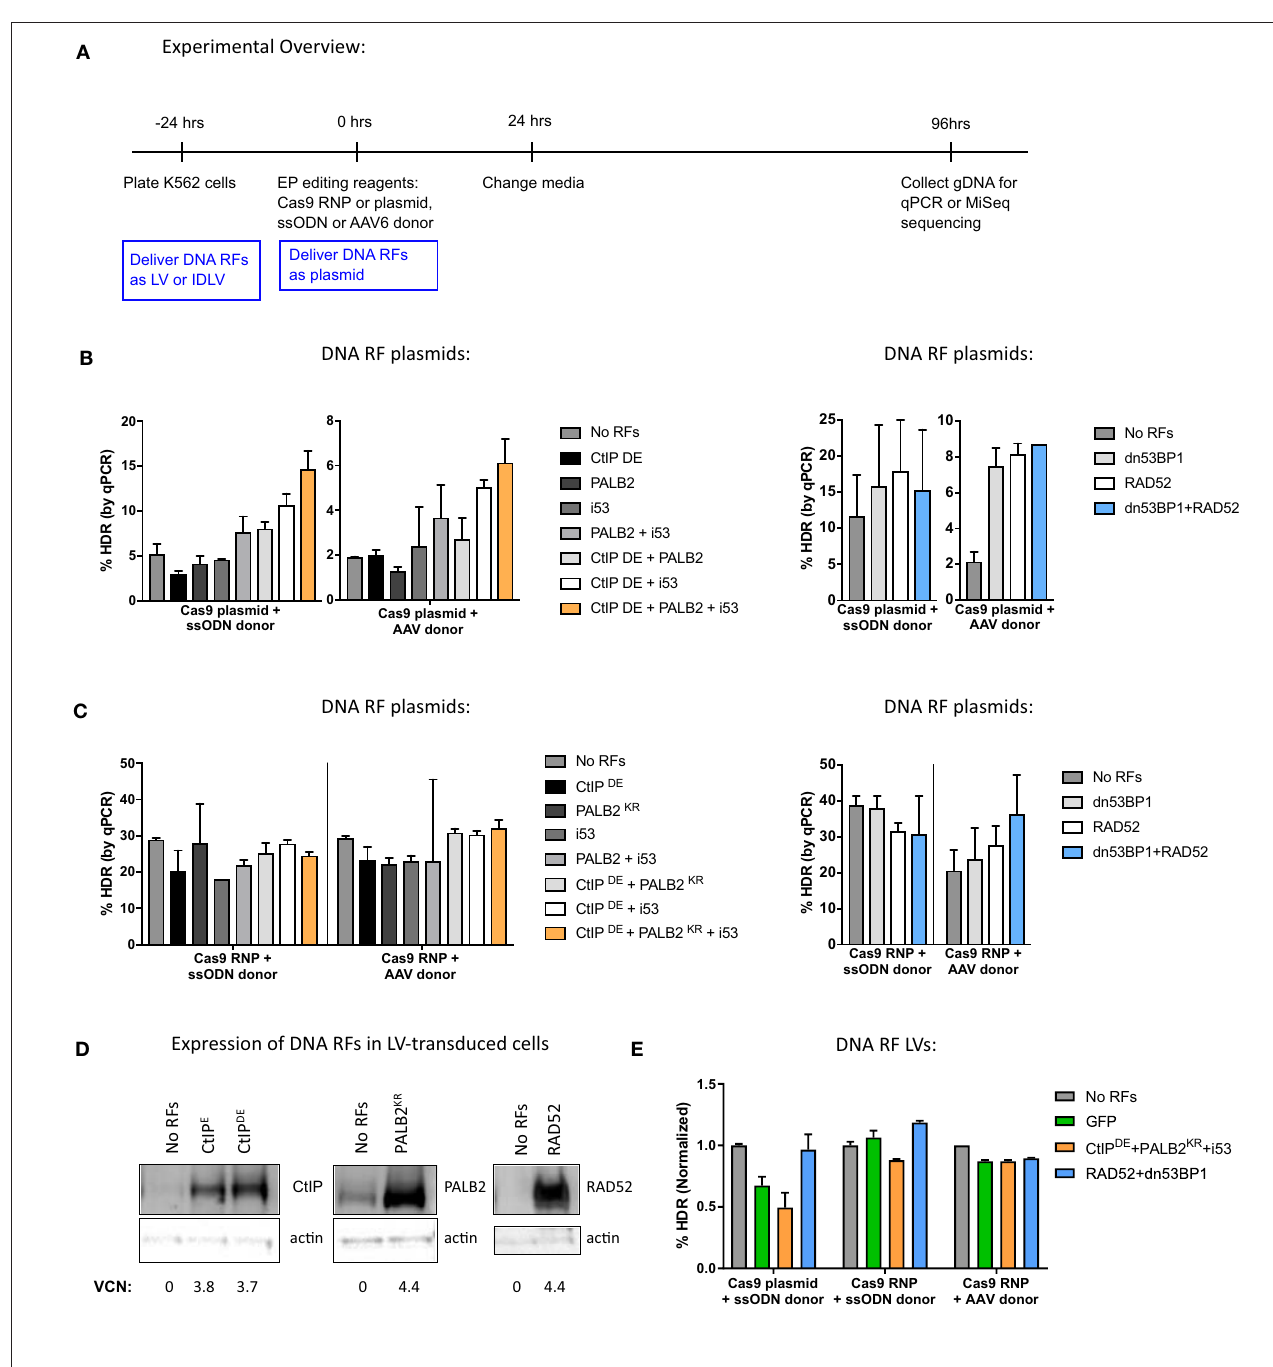
FIGURE 1 | The method for delivery of DNA repair factors (RFs) for global overexpression in K562 differentially affects gene editing outcomes. (A) Experimental overview of K562 cell transduction and electroporation for delivery of DNA RFs and editing reagents. DNA RFs delivered as plasmid were co-electroporated with editing reagents, while delivery of DNA RFs as LVs occurred 24h prior to electroporation. (B,C) Cas9 nuclease was delivered either as plasmid (1 µ g) or RNP (100 pmol Cas9 protein + 4.5 µ g of IVT sgRNA); donor template was delivered either as ssODN (3 µ M) or AAV6 (MOI 2e4). DNA RFs were delivered as a plasmid. HDR levels were measured by qPCR. n = 2 biological replicates for CtIP DE + PALB2 KR + i53 experiments, n = 6 biological replicates for RAD52 + dn53BP1 experiments. Error bars, mean ± SD. (D) K562 cells were transduced with LVs expressing the indicated DNA RFs. Western Blot was performed on day 10 post-transduction. Vector copy number (VCN) was determined by droplet digital PCR (ddPCR). (E) K562 cells were transduced with DNA RF LVs and electroporated with editing reagents. n = 2 biological replicates. Data are normalized to “No RFs” conditions for each set of experiments. Error bars, mean ± SD.